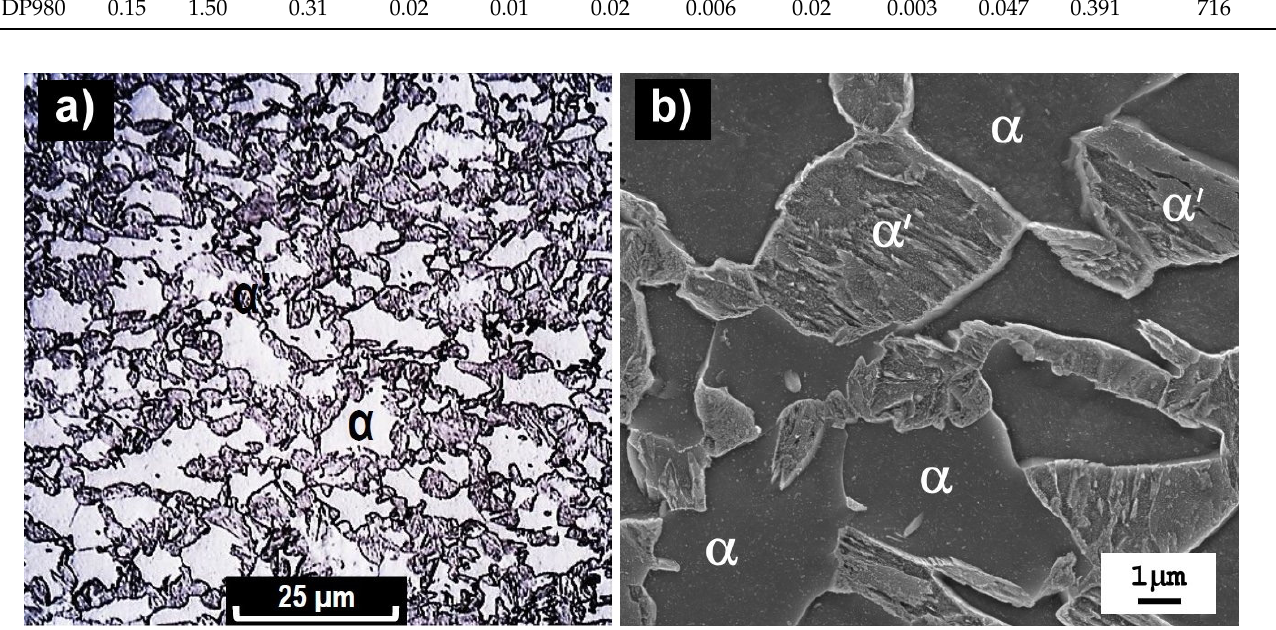
Table 1. Chemical composition of DP980 steel sheet (wt.%). Table 2. Uniaxial tensile properties and hardness of DP980 steel. Material